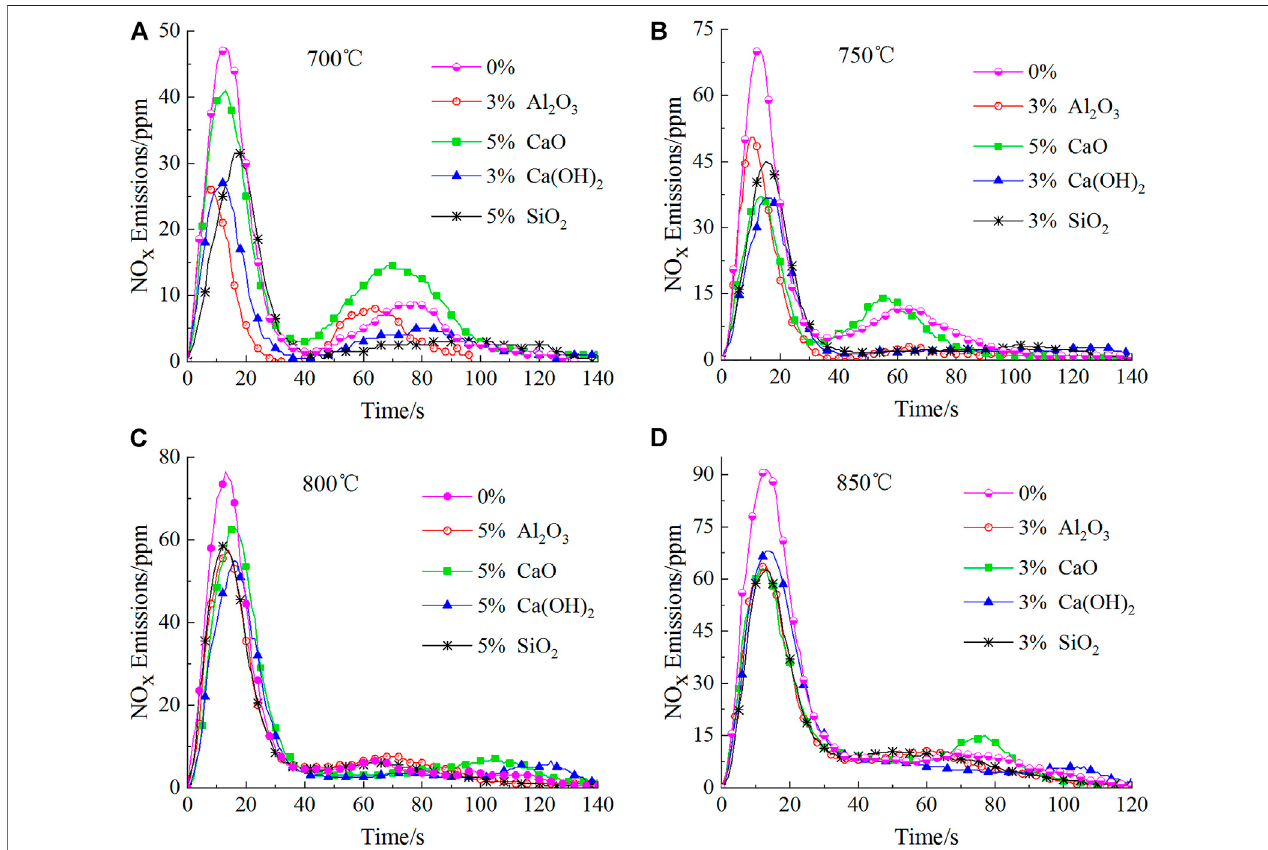
FIGURE 5 | Emission curves for the four additives at their optimal mass fractions at different